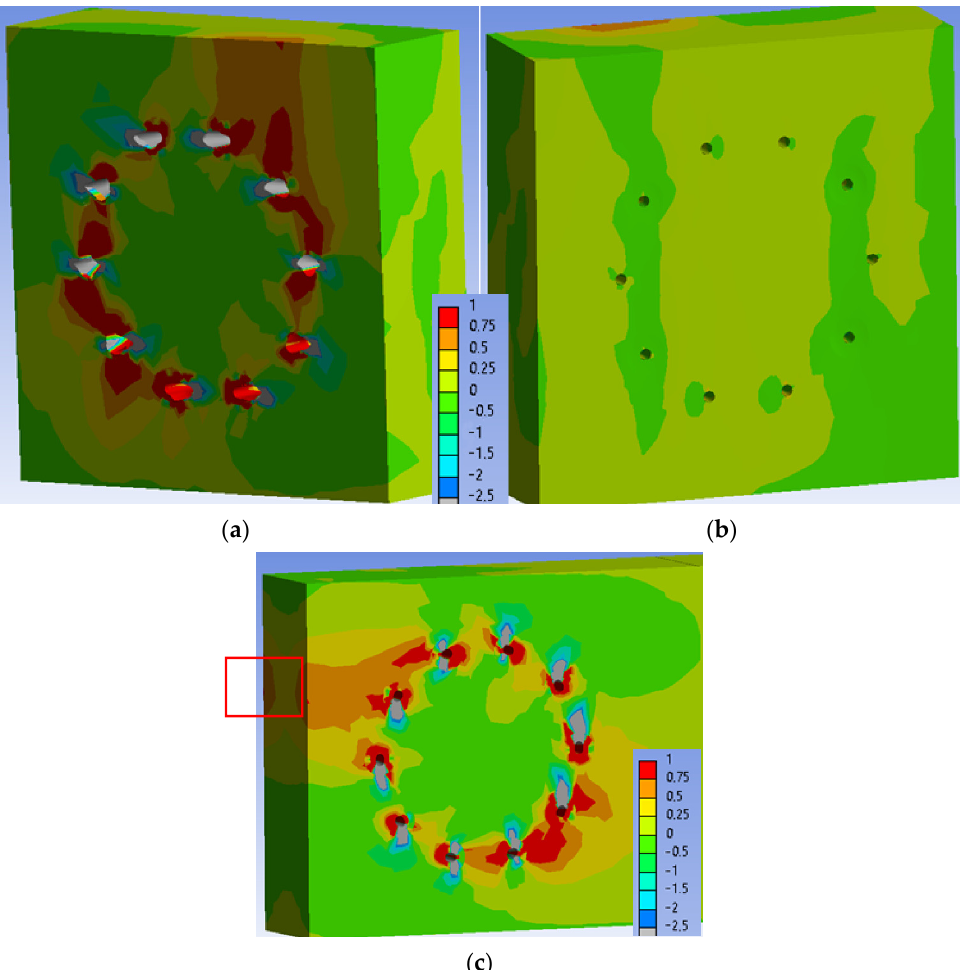
Figure 24. Tensile stress perpendicular to the grain [MPa] at 80% ULS, Experiment A: ( a ) inner side of the stand; ( b ) outer side of the stand; ( c ) rung.